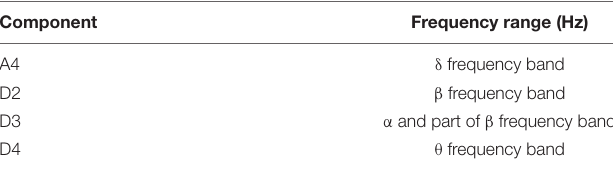
TABLE 3 | Correlation between wavelet components and the EEG signal frequency band. Component